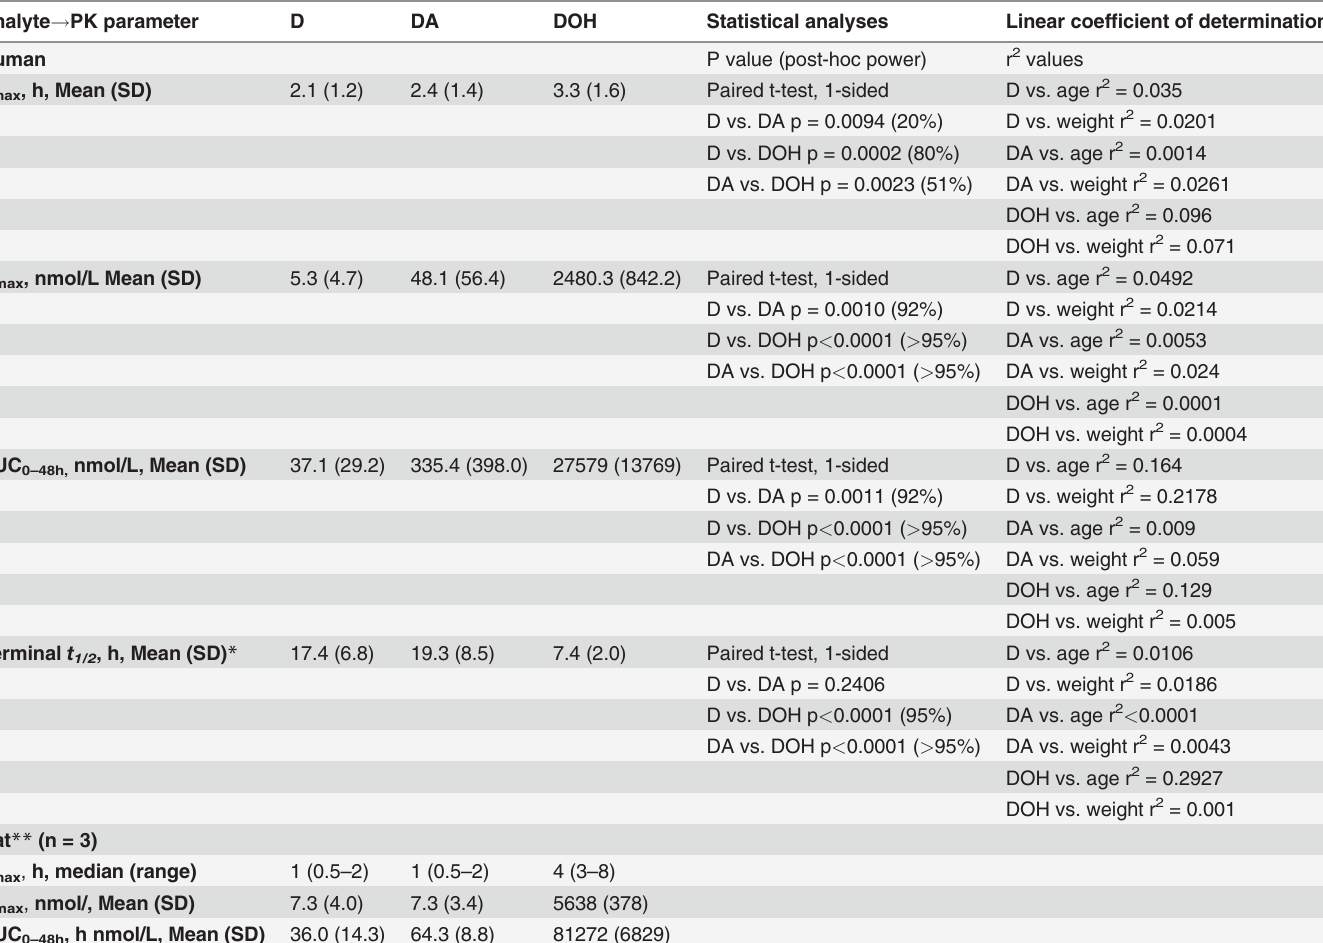
Table 2. Key pharmacokinetic parameters of decursin (D), decursinol angelate (DA) and decursinol (DOH) in all human subjects (n = 20) receiving dietary supplement Cogni.Q orally vs. those in rats. Analyte ! PK